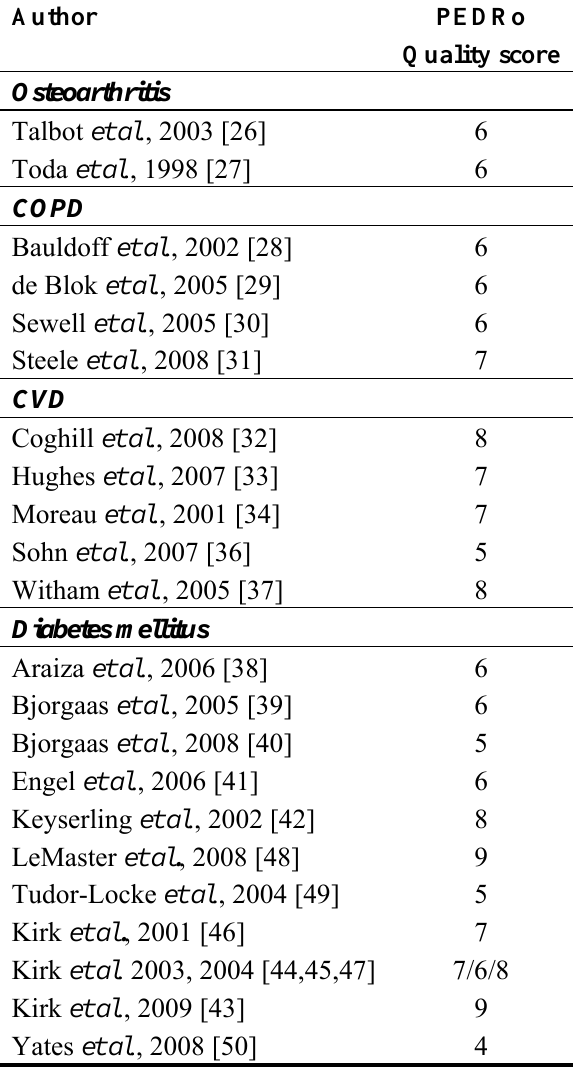
Table 1. Overview of